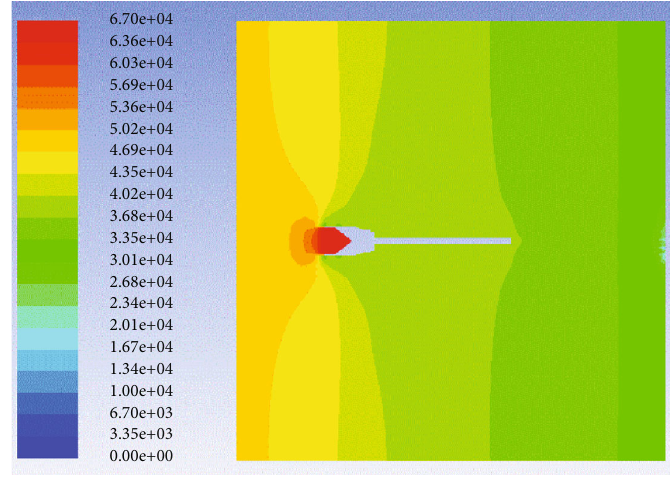
Figure 13: Pressure contour when v = 50 m / s , α = 0 ∘ .